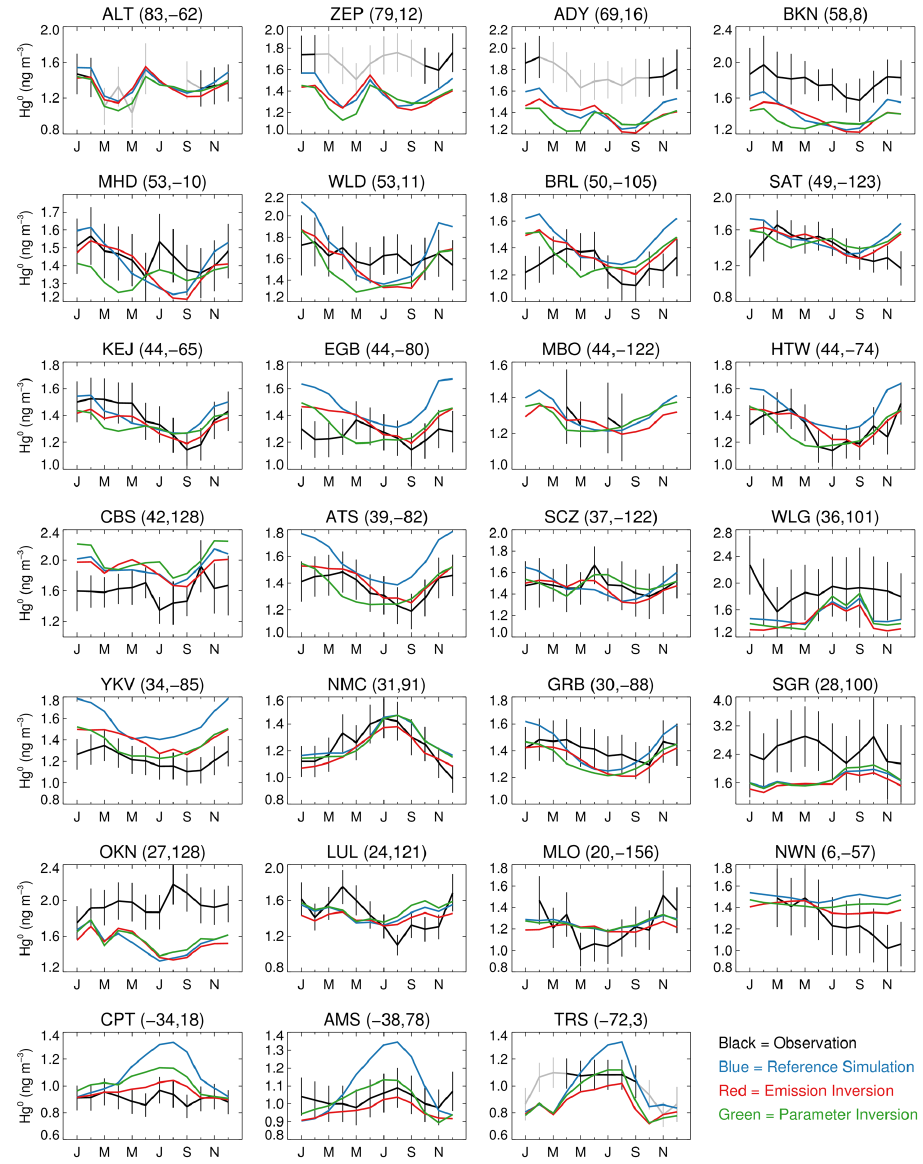
Figure 3. Monthly Hg 0 concentrations for all ground-based observational sites. Note different scales on vertical axes. Error bars correspond to the total errors described in Sect. 2.6. The two numbers in parentheses after the name of each site are its latitude and longitude. For polar sites (ALT, ZEP, ADY, and TRS), the gray color shows the observed Hg 0 concentrations that are not used in our inversions due to AMDEs, as shown in Sect.